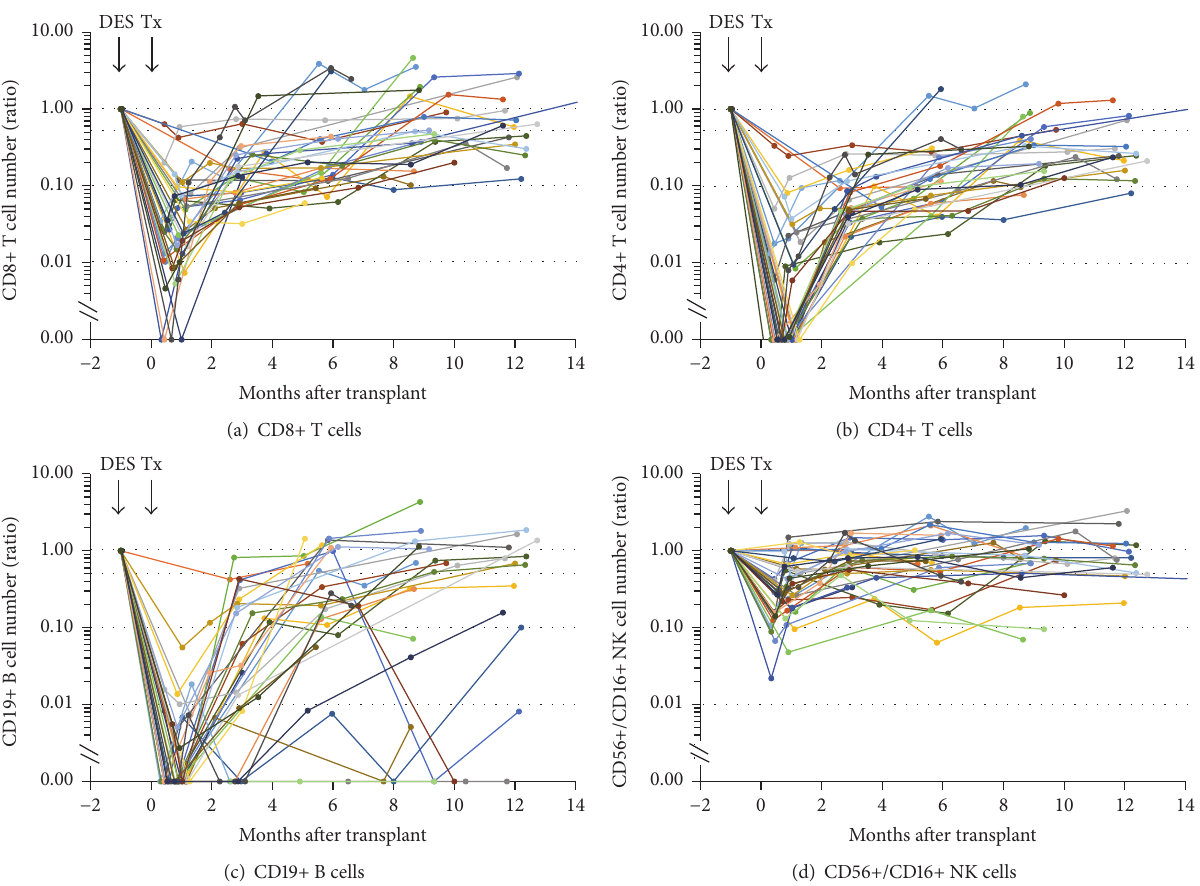
Figure 1: The number of CD8+ (a), CD4+ T cells (b), CD19+ B cells (c), and CD56+/CD16+ NK cells (d) pre-DES and posttransplant in 36 DES patients who received DES with IVIg + rituximab followed by a kidney transplant with alemtuzumab induction. Each line with each symbol describes the result from one patient. The results were expressed as the ratio against the pre-DES level in each patient. DES: desensitization; Tx: